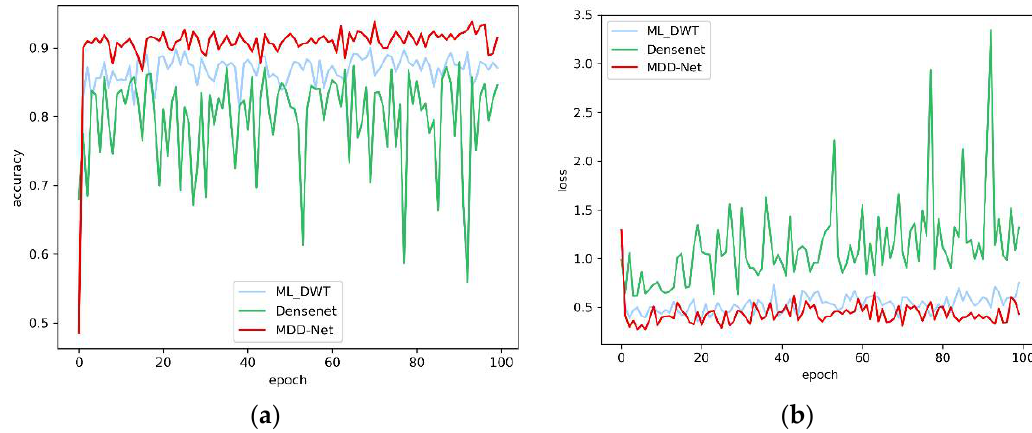
Figure 10. The overall accuracy and loss curves of models on the test set. ( a ) Overall accuracy; ( b ) Loss.